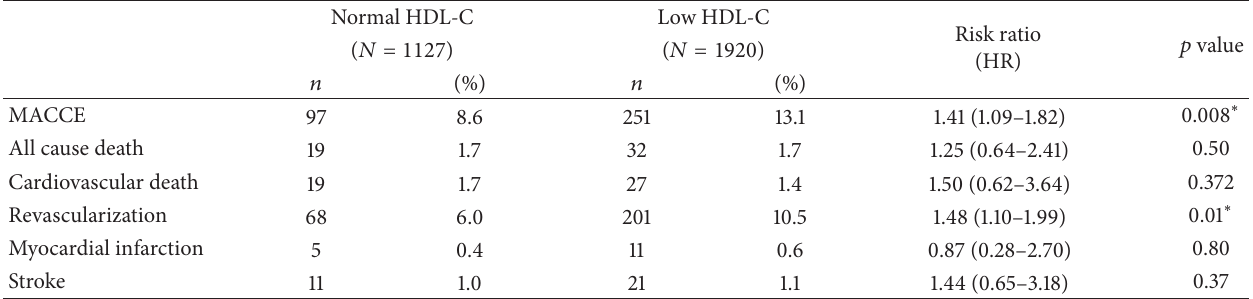
Table 2: The comparison of MACCE between normal HDL-C group and low HDL-C group.